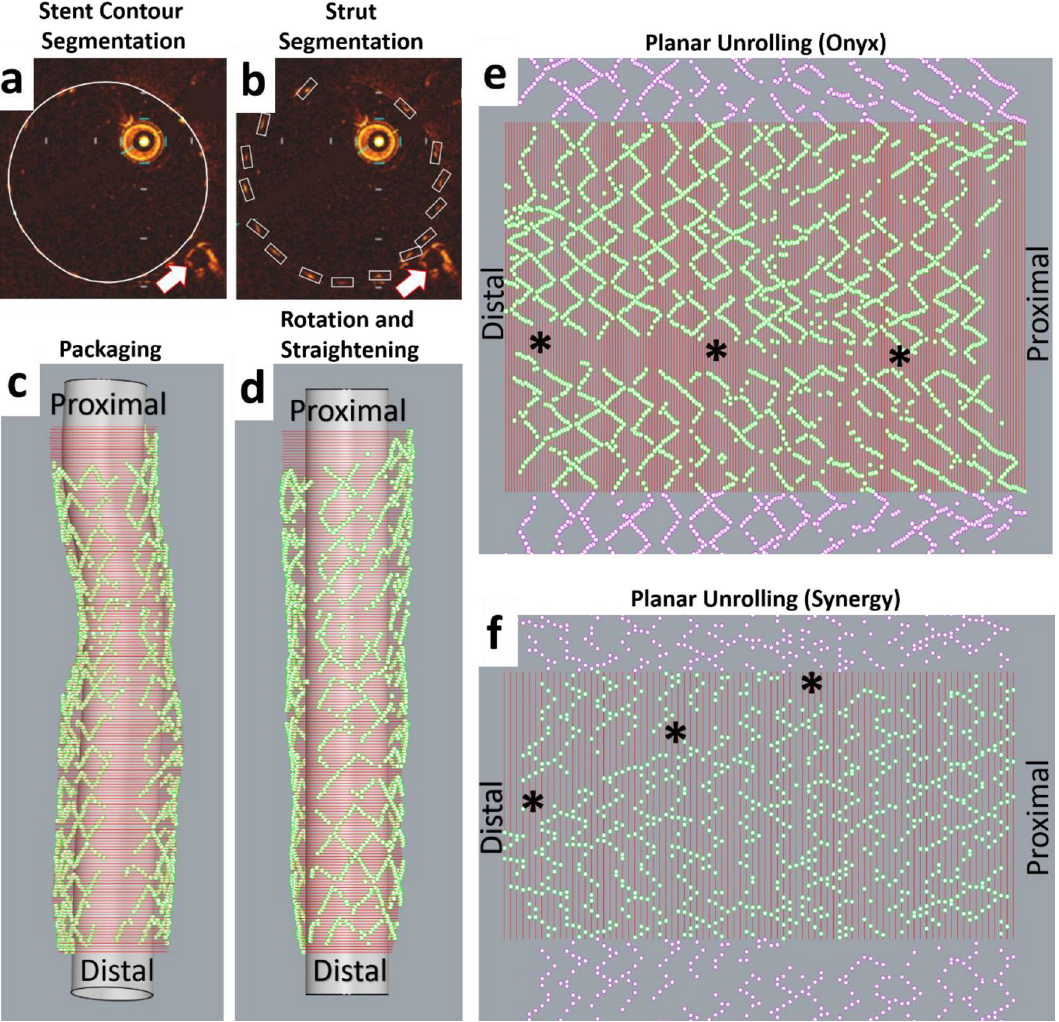
the 3D reconstructed lumen, (c) Packaging of segmented stent contours and strut points in space, (d) Rotation and straightening of the packaged stent contours and strut points, (e, f) Planar unrolling (stent contours in red, stent strut points in green). The purple strut points were added to show the continuity of the stent structure. In (e, f) , note the zone of missing strut points corresponding to the wire shadow. (a–e) Depict Onyx stent and (f) Synergy